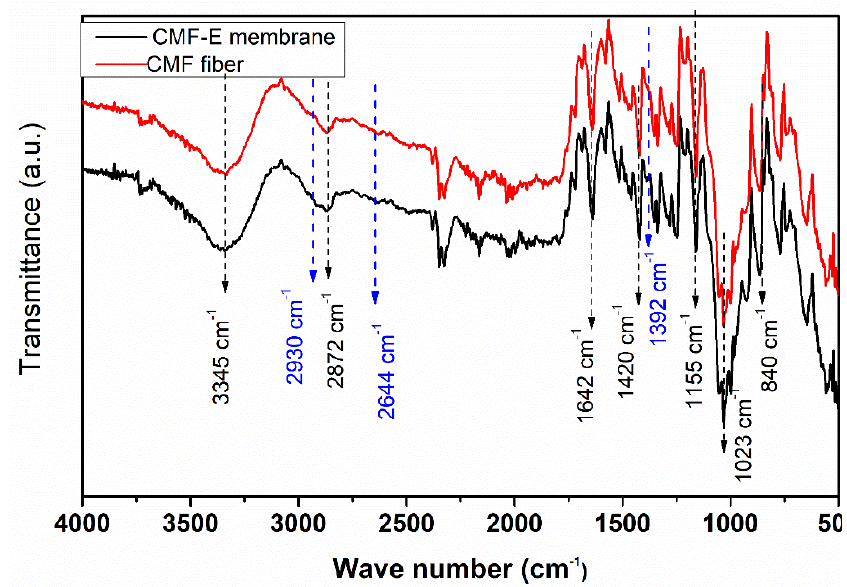
Figure 4. FTIR spectra of the different samples.